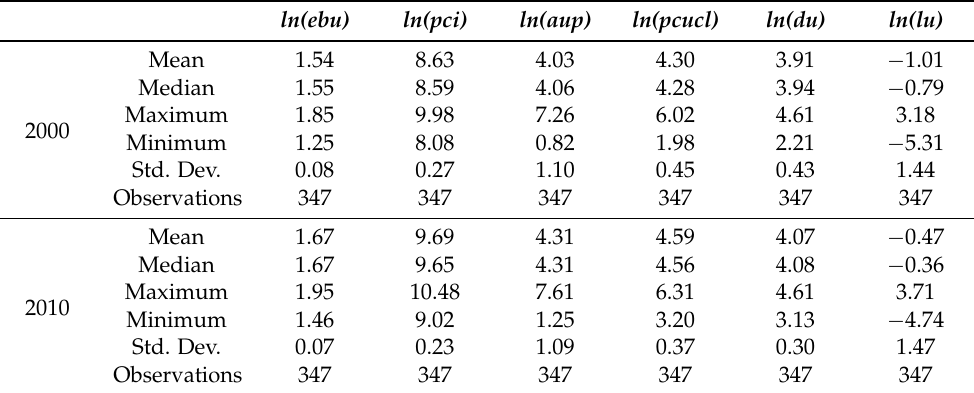
Table 6. Statistical description of variables in 2000 and